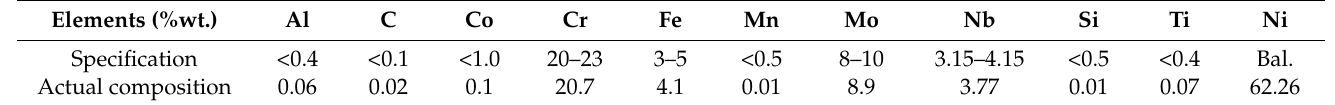
Table 1. Chemical composition of IN